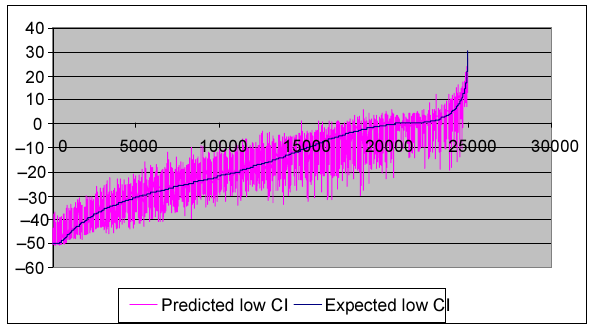
Fig. 6 contrasts the predicted values of payment risk with the expected values. In this plot, the dark solid line repre- sents the expected value of mean risk for a particular set of input parameter values. The lighter band around it is formed by plotting the corresponding predicted values. The thickness of the band shows the spread in prediction. Smaller spread would mean that the predicted mean risks are closer to the expected mean risks and hence errors are small and vice-versa. In the sample result, the spread in mean risk is almost ± 7.5% for the first part of the plot.